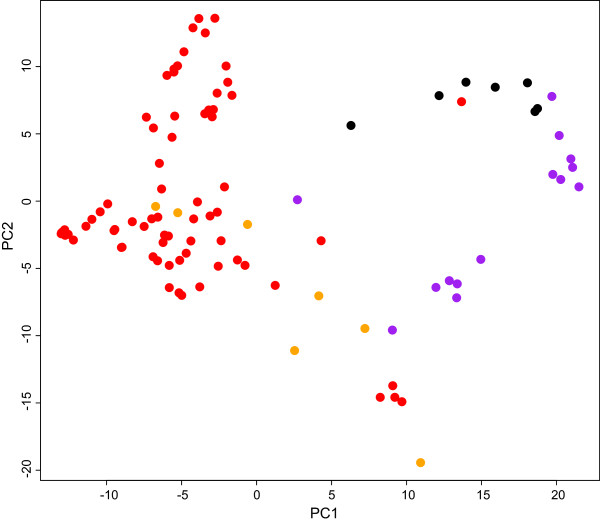
Linkage disequilibrium (r2) between linked markers, located 20 cM or less apart, plotted against the genetic distance with a non-linear regression line fitted to the values. a) All tetraploid wheats; b) durum landraces only.